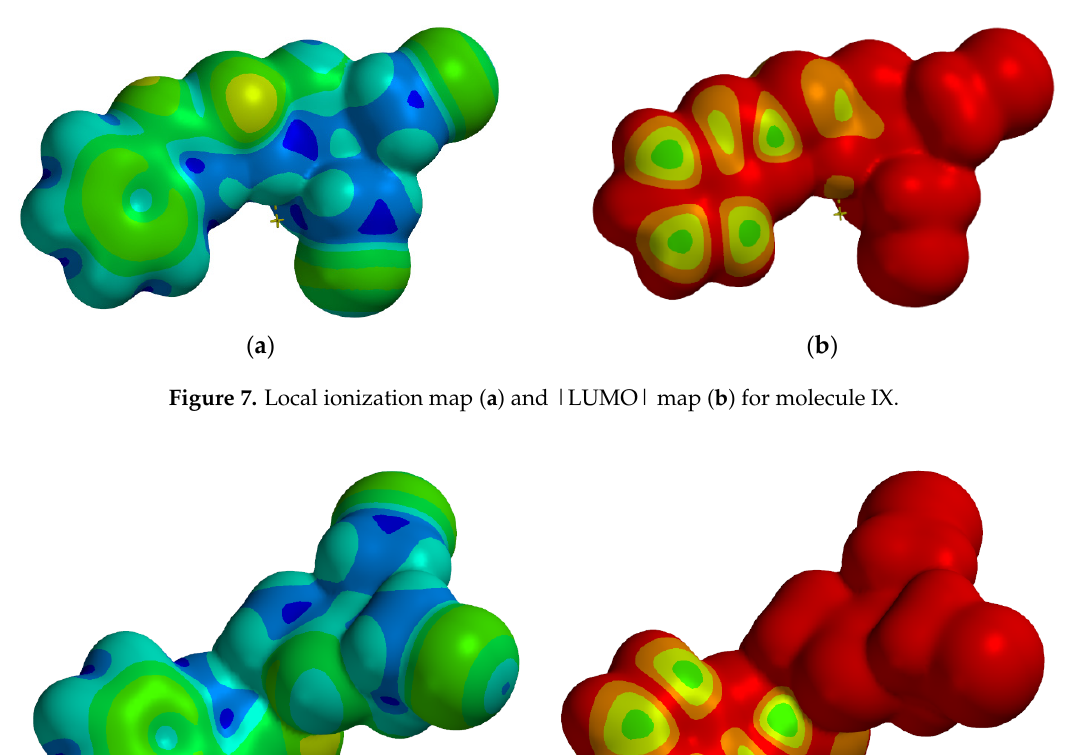
Figure 6. Local ionization map ( a ) and |LUMO| map ( b ) for molecule VIII.